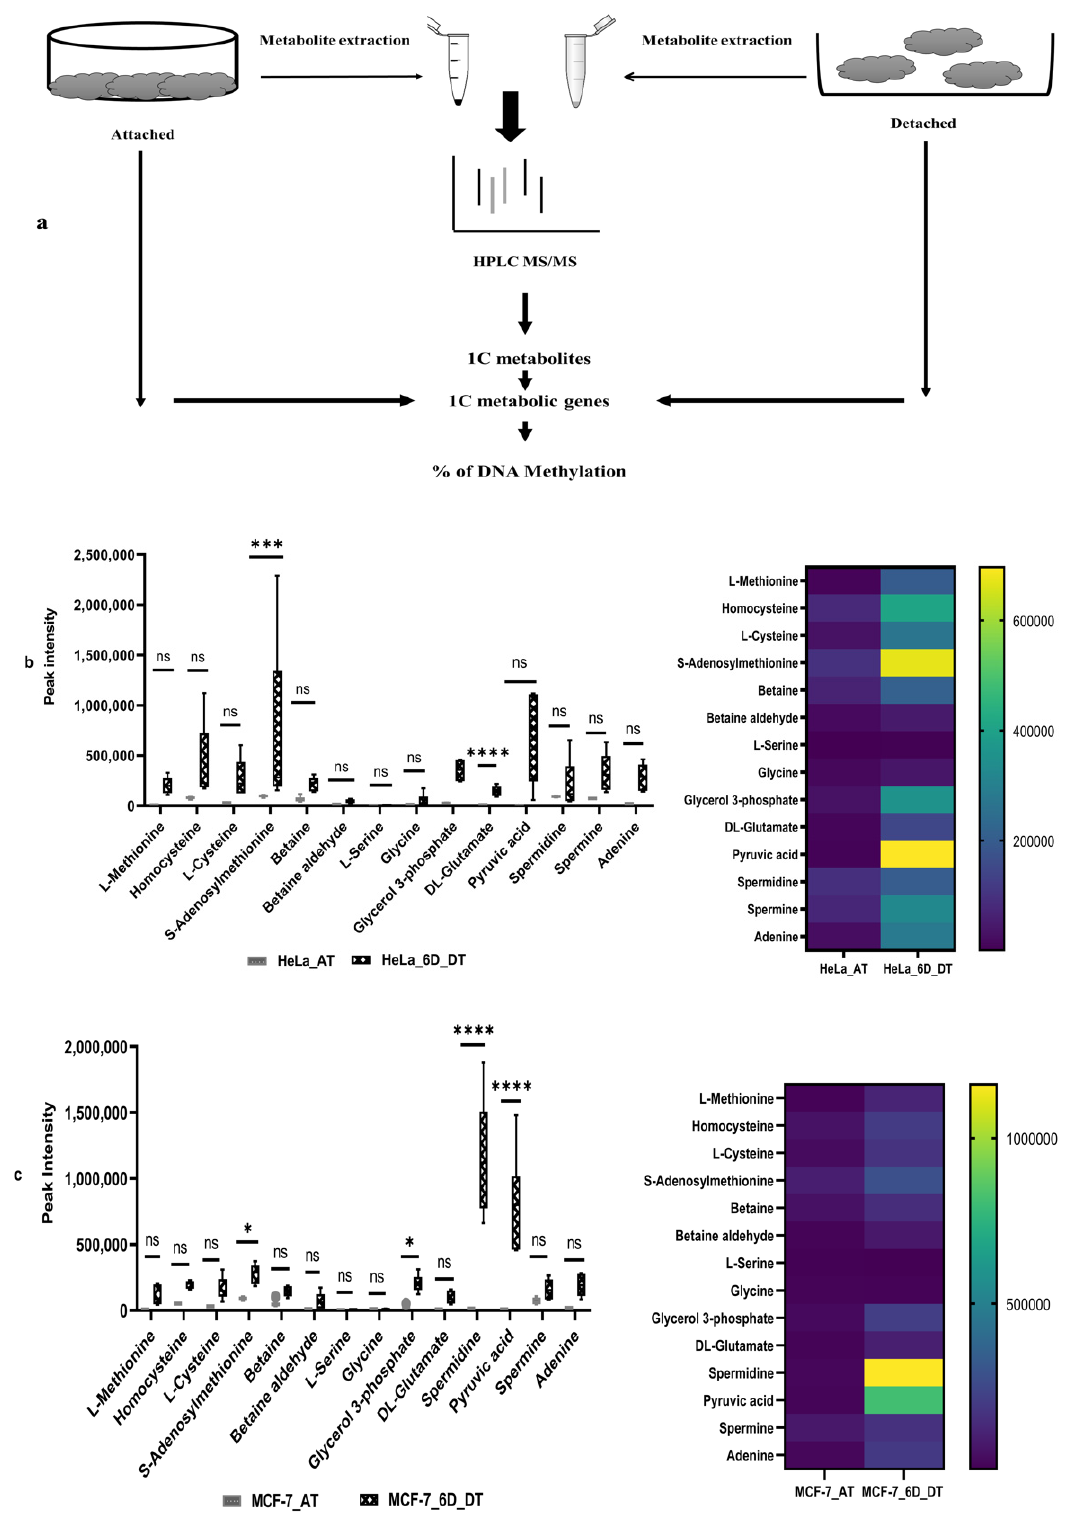
Figure 1. Increasing the level of one-carbon metabolites in the ECM-detached condition. ( a ) Overall experimental design. ( b ) The one-carbon metabolites detected in the attached (AT) and 6 days (6D) ECM-detached HeLa cell line. ( c ) The one-carbon metabolites detected in the attached (AT) and 6 days (6D) ECM-detached MCF-7 cell line. The data are presented as mean ± SEM; ns, not significant; * p < 0.05, *** p < 0.001 and **** p < 0.0001.